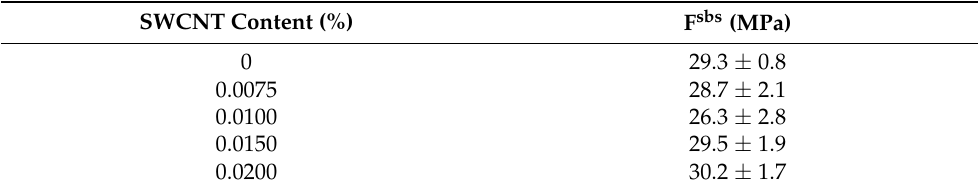
Table 1. Flexural properties of manufactured